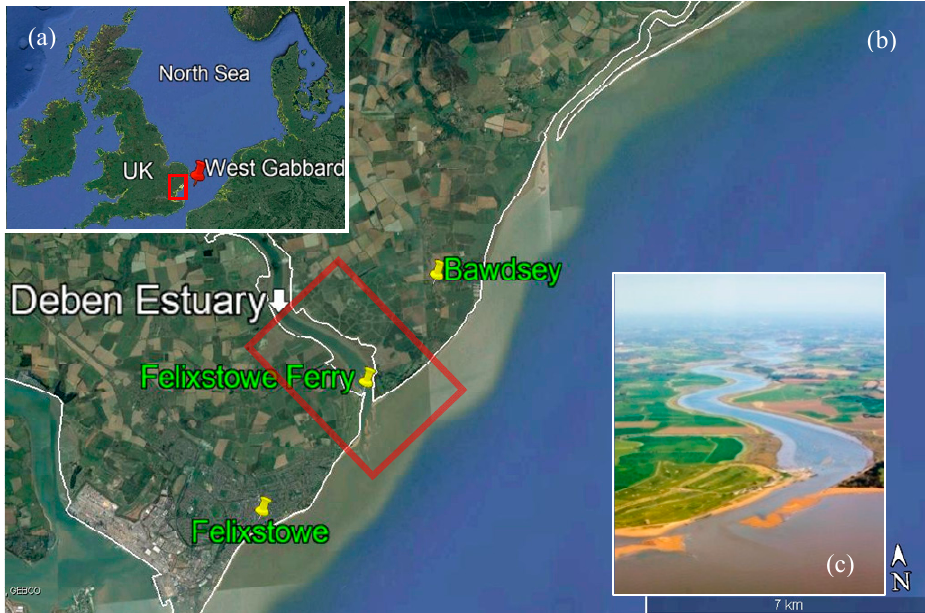
Figure 1. The location of Deben Estuary in the UK (the red square in ( a )), Deben surroundings ( b ) [extracted from Google maps] and close view of the inlet area of estuary ( c ) [photo from website of River Deben Association: riverdeben.org]. The wave buoy ‘West Gabbard’ is shown by the red marker in ( a ). The estuary inlet is marked in red square in ( b ).